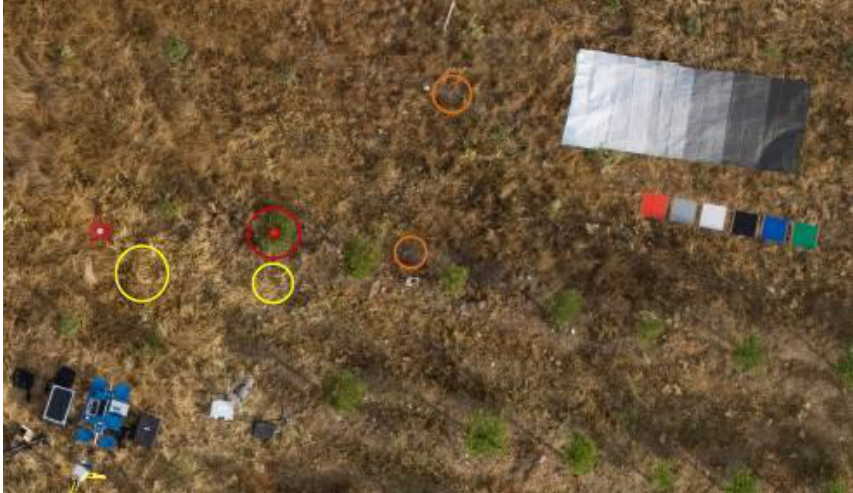
Figure 8. Aerial image of the control and check